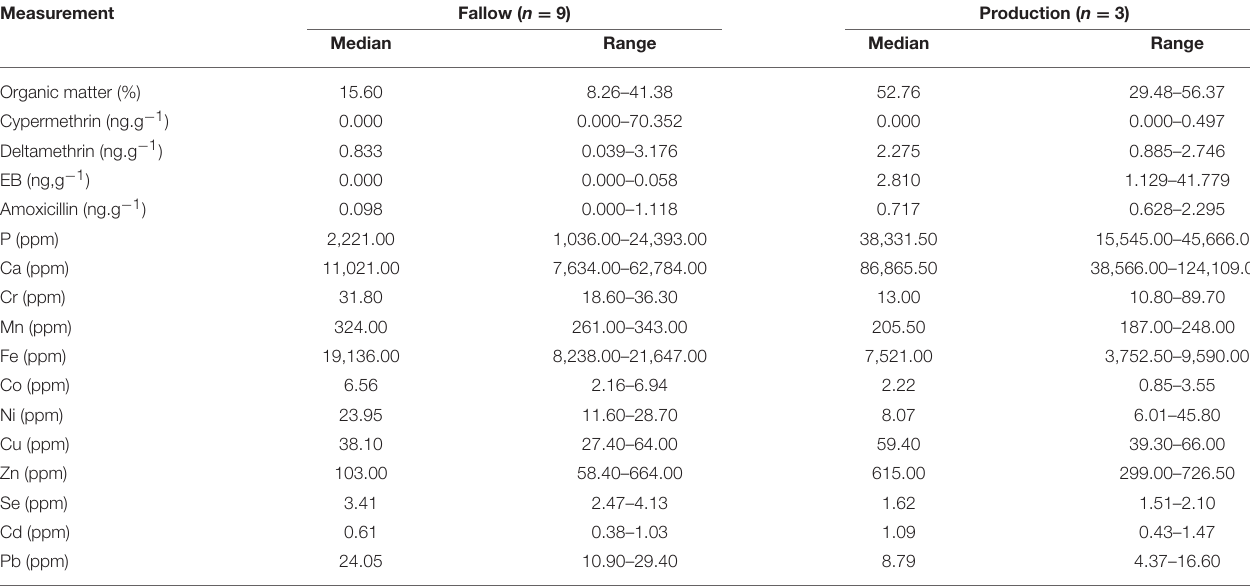
TABLE 1 | Concentration of OM, elements, and chemotherapeutants (median and range) contained in 9 samples of flocculent matter collected at a fallowed site and 3 at a production site (5 months).